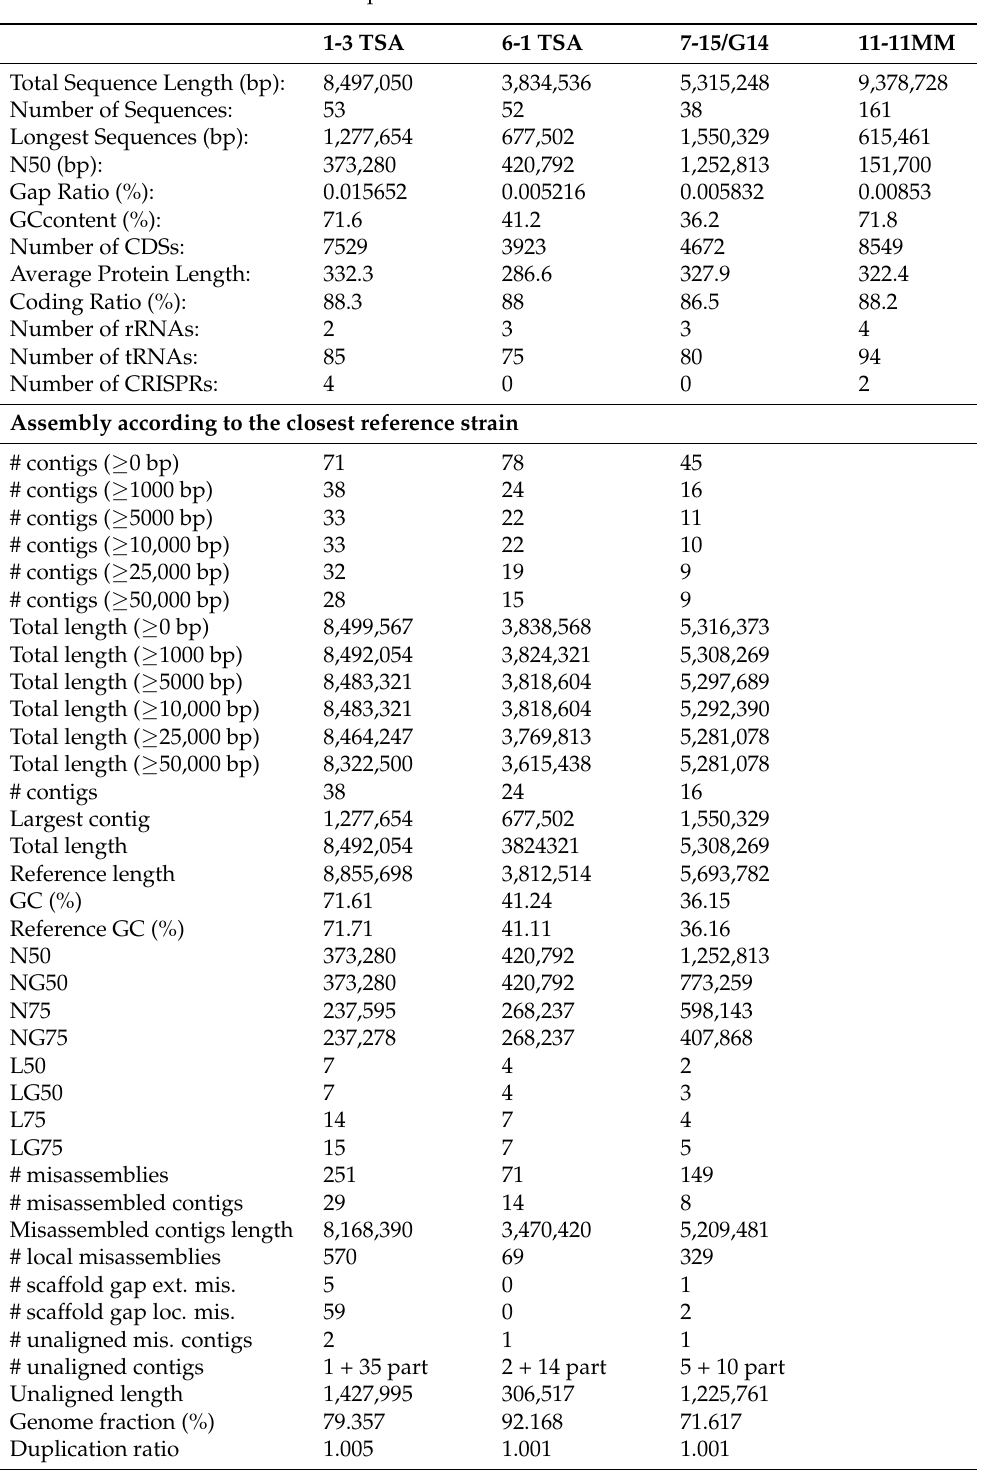
Table 4. Genome annotation and comparison with the closest reference